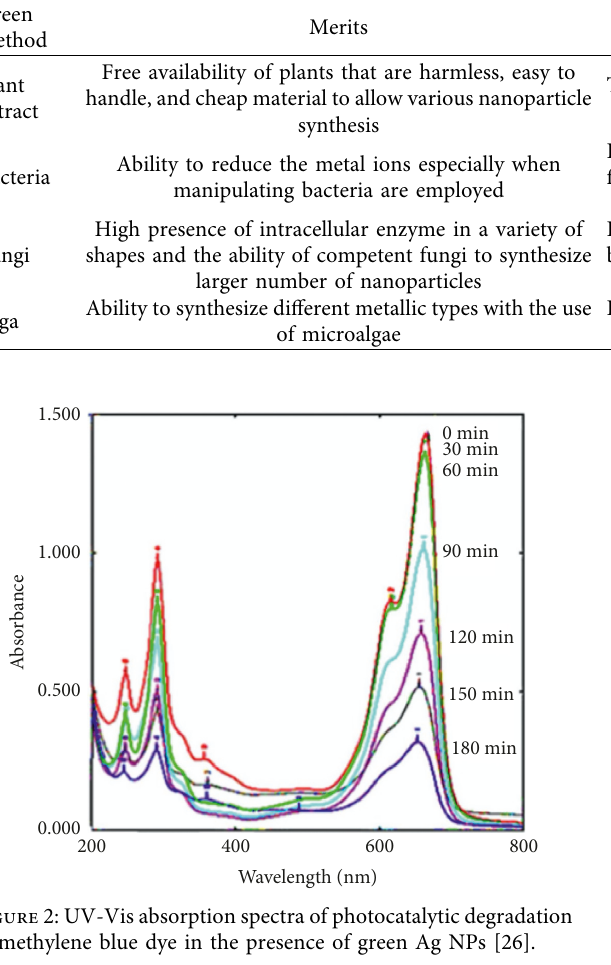
Table 1: General merits and demerits of the main green routes for nanoparticle synthesis.